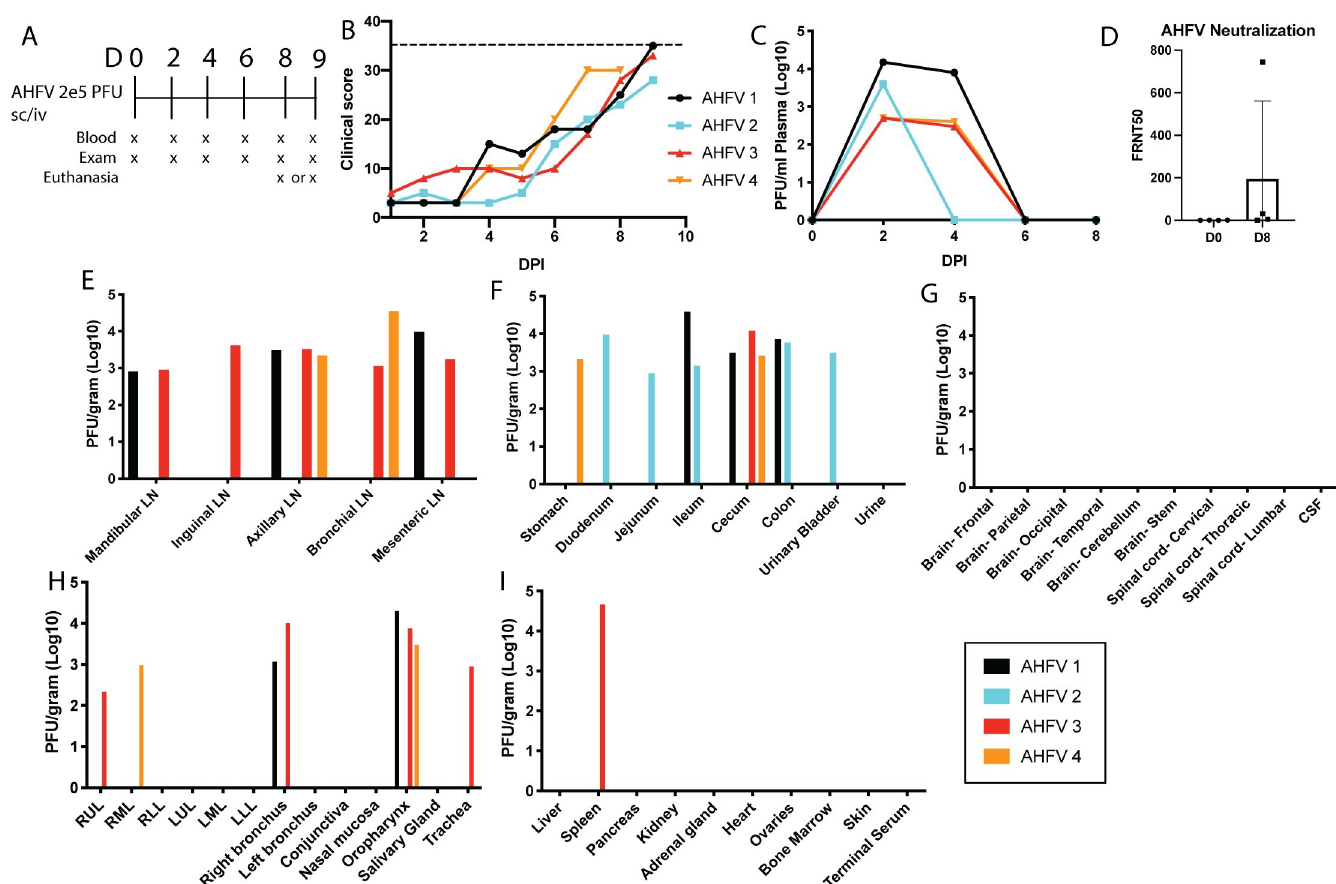
Fig 2. Pigtailed macaques are susceptible to disease caused by AHFV. Four pigtailed macaques (AHFV 1–4) were infected with 2 x 10 5 pfu AHFV 200300001 sc/iv and monitored for clinical illness. A. Schedule for blood draws and exams in AHFV-infected animals. B. Clinical scores in four pigtailed macaques following infection with AHFV. Dotted line represents a score of 35. C. Viremia was measured in plasma over the first 8 days of infection by plaque assay. D. Neutralization assays were performed using a focus reduction neutralization assay. FRNT50 values are reported. Error bars show the SD across four animals. Statistics were performed using an ordinary one-way ANOVA ( N = 4, � P < 0.05). E-I. At day 8 or 9 post infection, virus present in the tissue homogenate was measured by limiting dilution plaque assay, and values were normalized to 1 gram of tissue. Data from each individual animal are